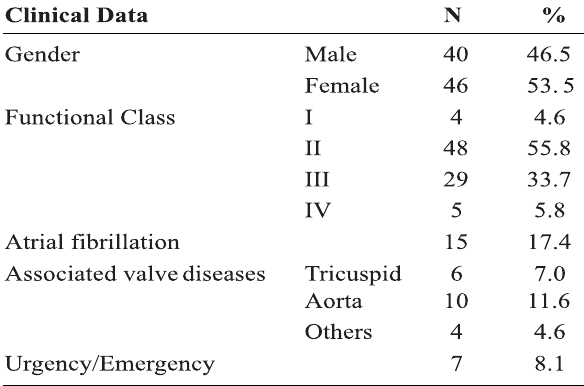
Table 1. Clinical data of the patients suffering from mitral insufficiency who underwent mitral valvuloplasty.